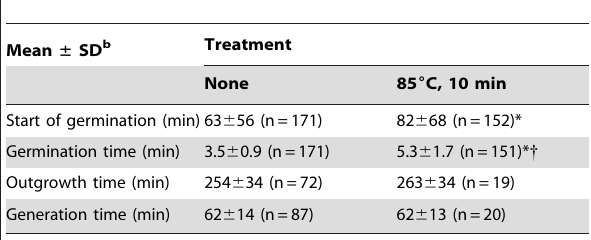
Table 2. Mean values and standard deviation of different stages of germination and outgrowth of untreated and wet- heat-treated individual B. subtilis spores a